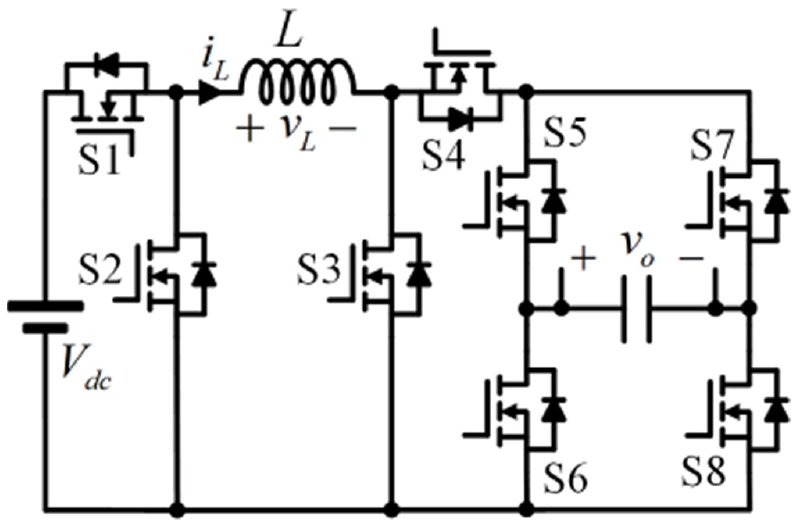
Figure 5. Buck-boost dc–dc/ac universal converter introduced in [27].